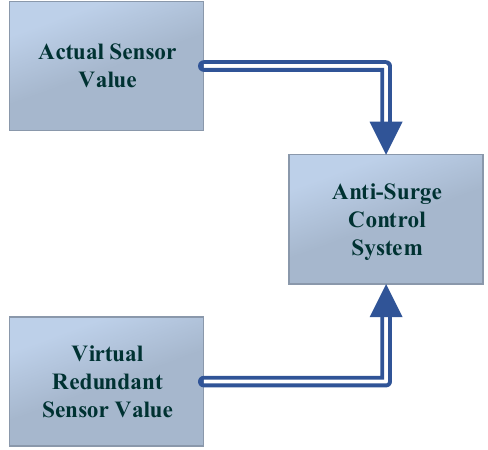
Figure 4. The analytical redundancy.